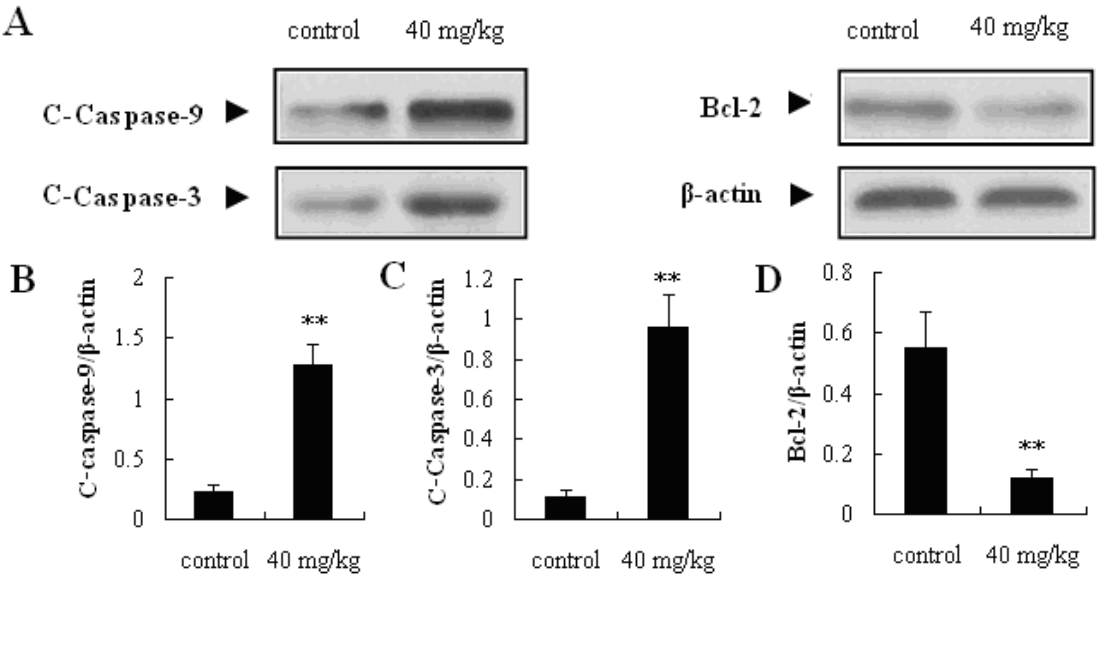
Figure 8. Effects of SBT-A on expressions of C-Caspase-3, C-Caspase-9 and Bcl-2 proteins in tumor tissues. The data are represented as mean ± S.D. ( n = 10). * p < 0.05 and ** p < 0.01 vs.